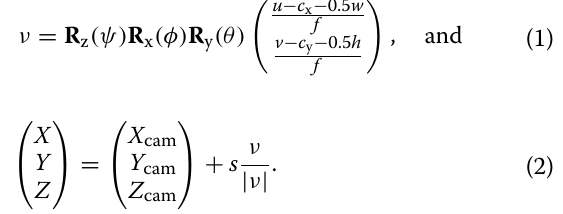
Table 1 Optical parameters of FLIR Zenmuse XT2 XT2